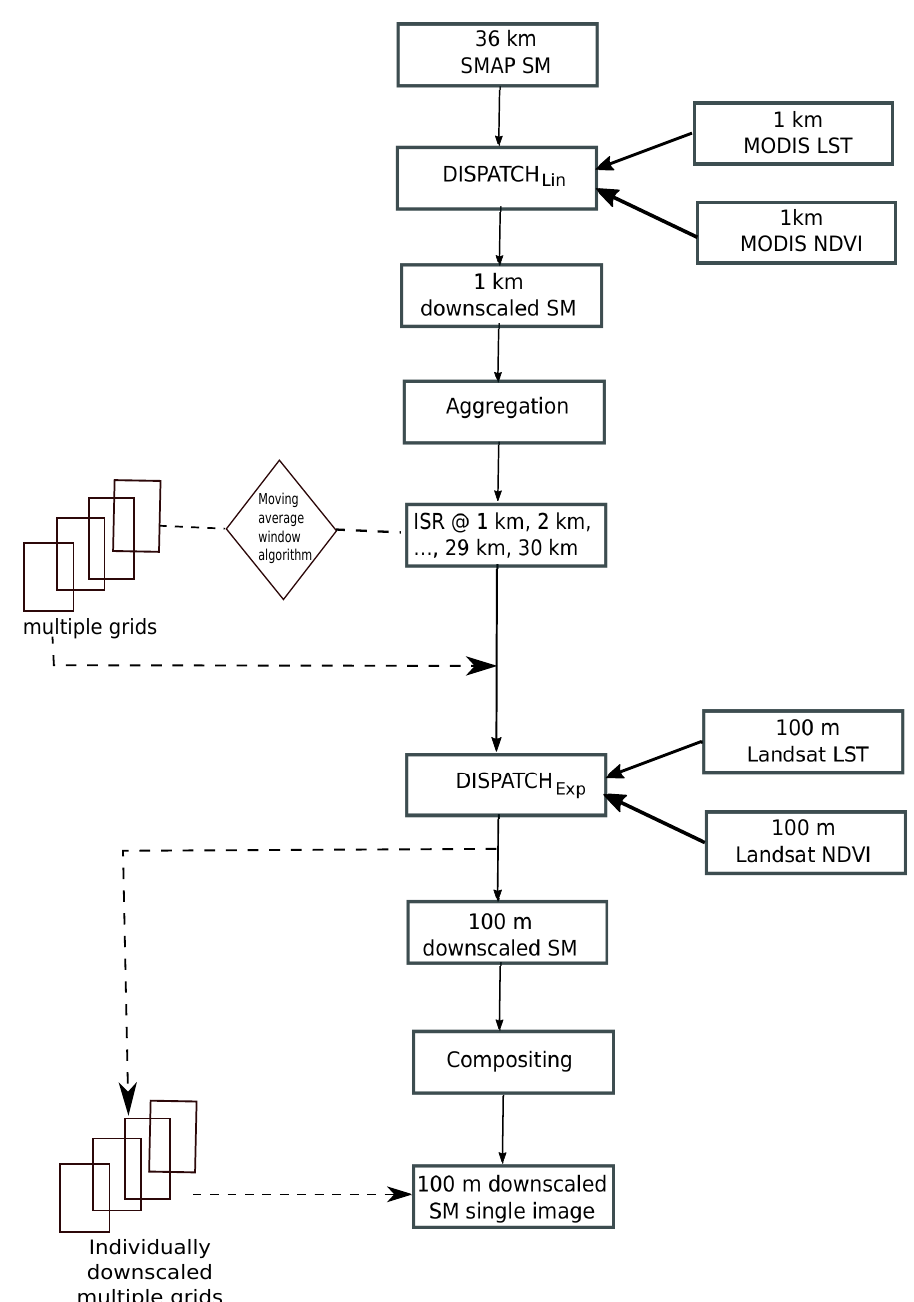
Figure 3. Flowchart of the stepwise sequential downscaling approach from 36 km resolution to 1 km (DISPATCH Lin ), from 1 km to ISR (aggregation to variable ISR), and from ISR to 100 m (DISPATCH Exp ). The reason for the selection of a range of ISRs is associated with the contextual nature of DISPATCH, which makes the determination of temperature endmembers i.e., T s , dry and T s , wet , and hence the 100 m resolution Landsat-derived SEE, dependent on the spatial extent [59]. In particular, the larger the spatial extent, the more heterogeneous the surface becomes. Therefore, the accuracy in forcing data remain relatively uniform (underlying assumption of the contextual